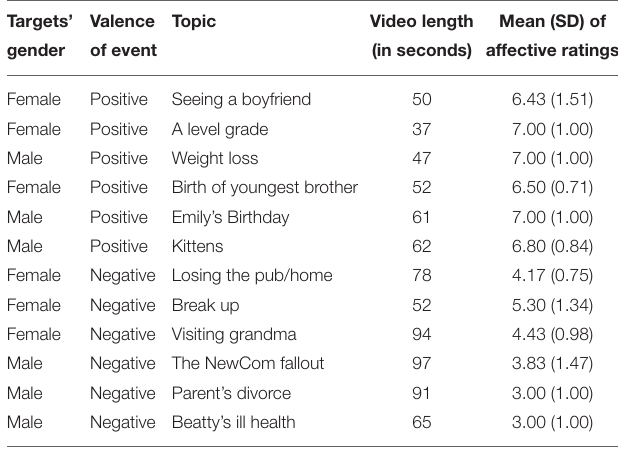
TABLE 3 | EA coefficients for each group.